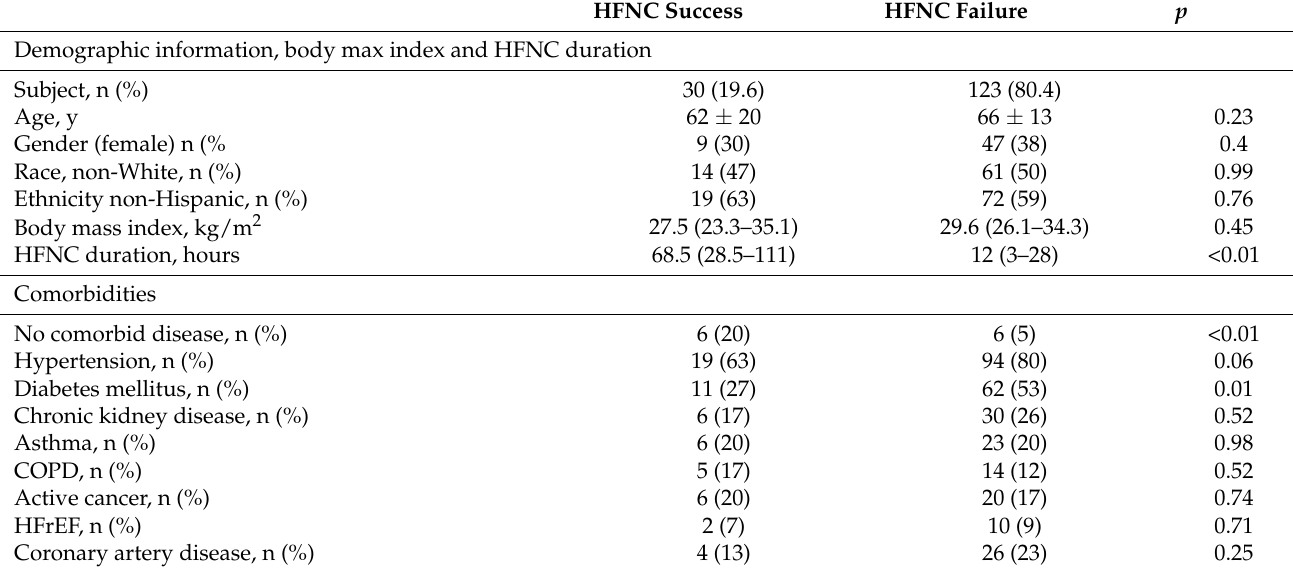
Table 3. Main demographic information, comorbidities, vital signs, laboratory results and x-ray findings compared between patients weaned off high-flow nasal cannula, and those who experi- enced HFNC failure and required intubation. Data are presented as mean [ ± SD], n [%] or median [interquartile range], unless otherwise